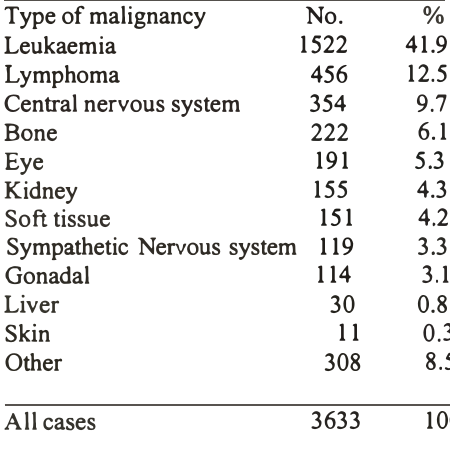
Table 2: Distribution of cases by criteria